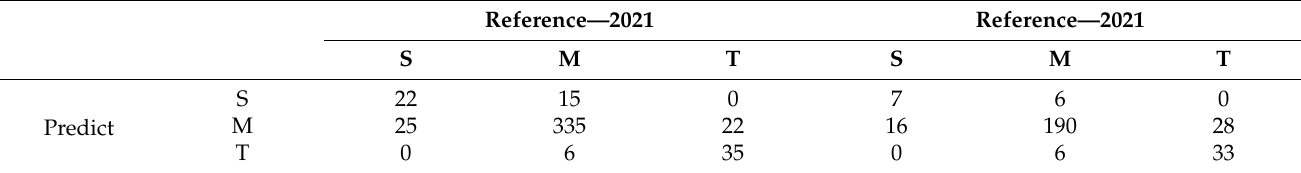
Table 5. Confusion matrix of DenseNet121 in years 2020 and